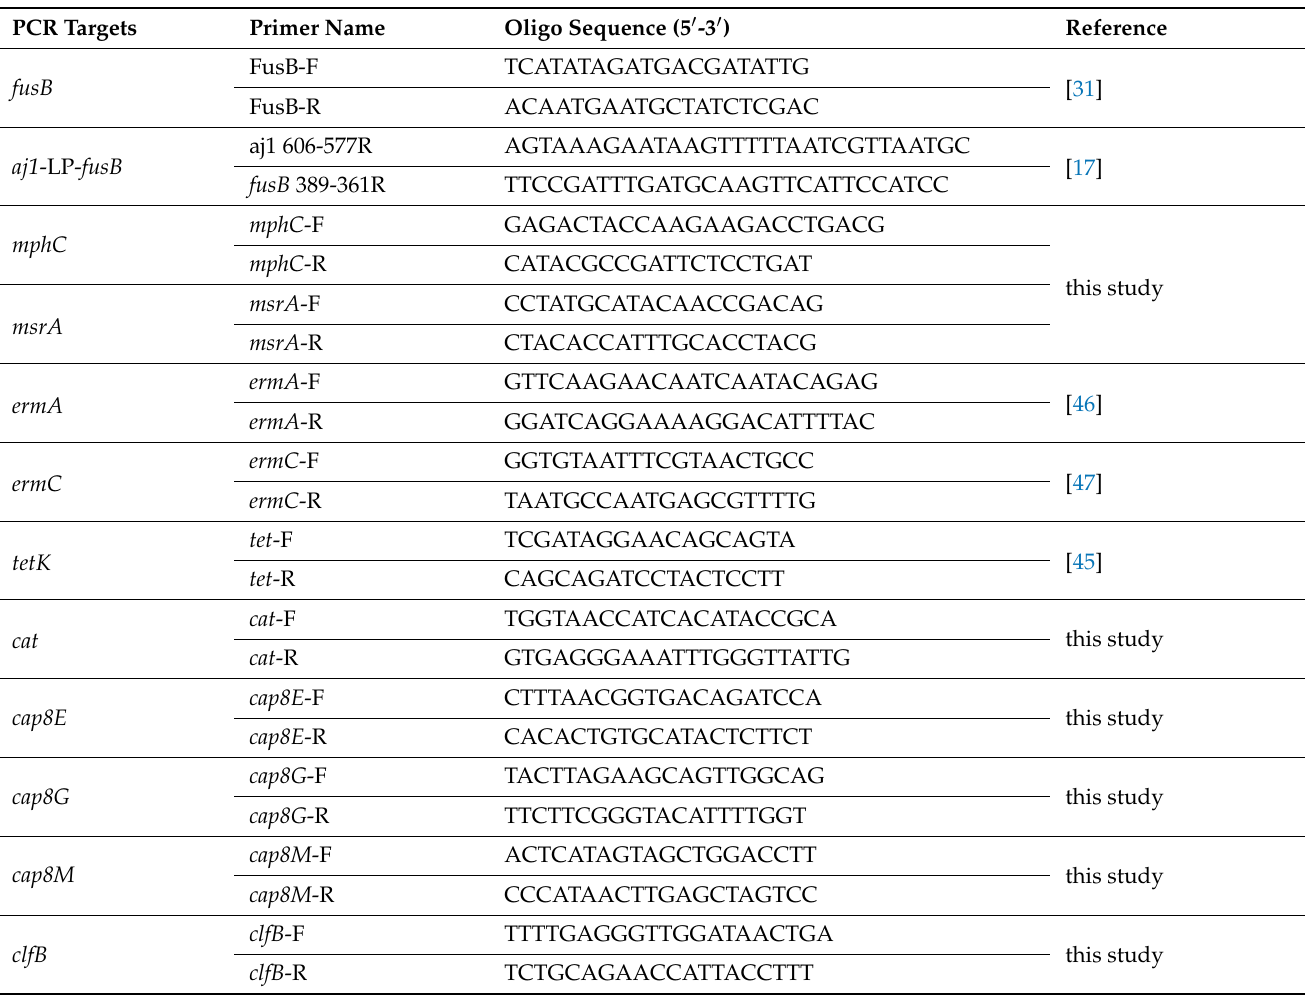
Table 4. Primers used in the